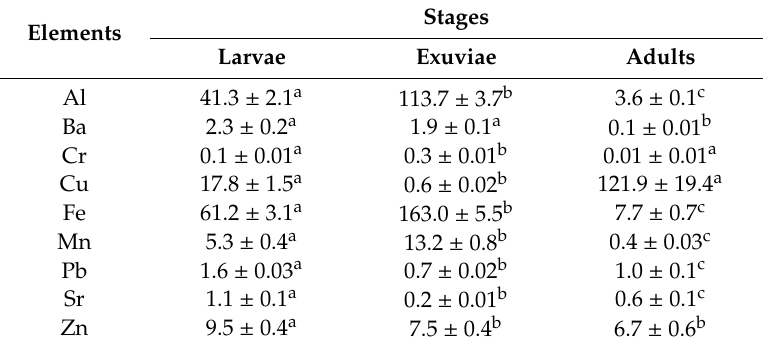
Table 3. Trace element contents per individual (expressed as mean ± SE, unit: µ g) of G. flavipes developmental stages in the Balsa studied area. Notations: di ff erent letters indicate the significant di ff erences at p < 0.05.